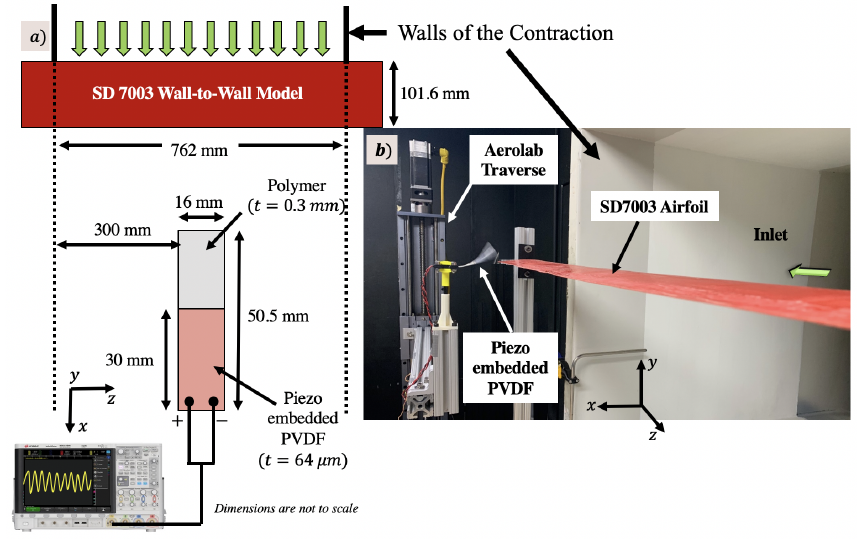
Figure 10. ( a ) Schematic of the SD7003 wall-to-wall model test setup; ( b ) picture of the test setup at